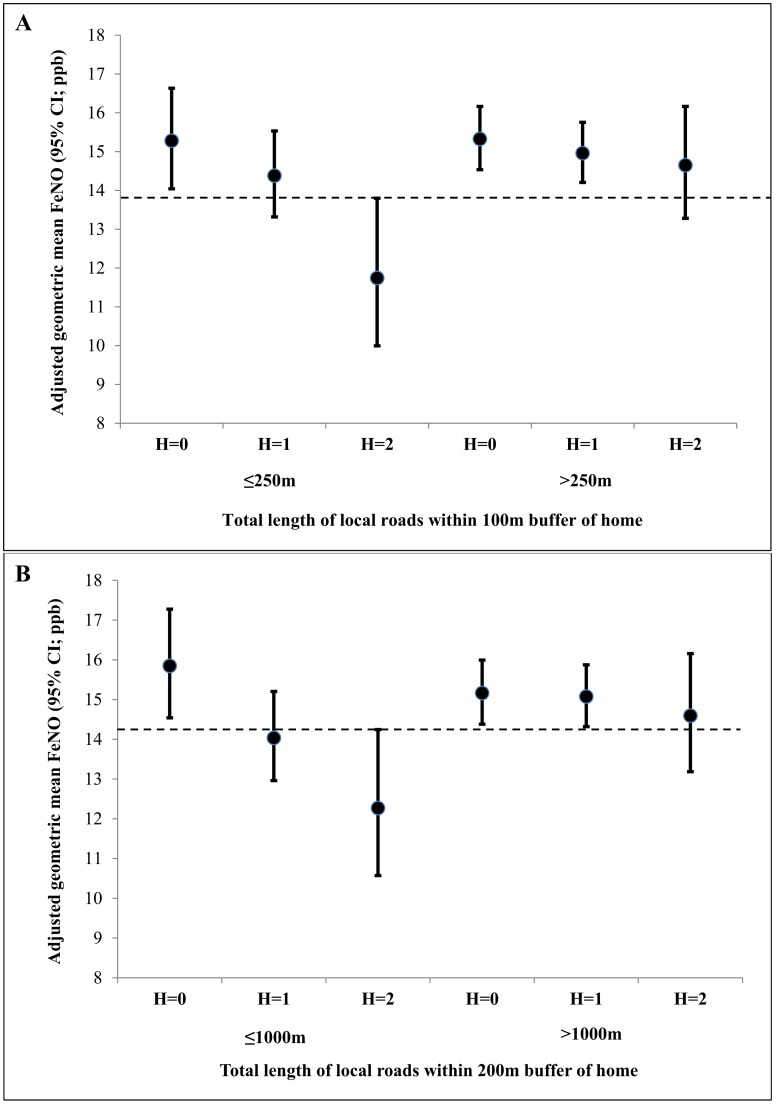
Influence of NOS2 H1 haplotype copies on the association between length of local roads around home and FeNO.The x-axis shows H1 haplotype copies (0, 1, and 2) within categories of local road-lengths within (A) 100m and (B) 200m circular buffers of home. The circles represent adjusted geometric mean FeNO and the vertical bars represent 95% confidence intervals. The 95%CIs for the adjusted geometric means that cross the dashed horizontal line in each figure are not statistically significantly different from the adjusted geometric mean FeNO in children who had 2 copies of the H1 haplotype and had less than 250m and 1000m total local road lengths within 100m and 200m buffers, respectively.